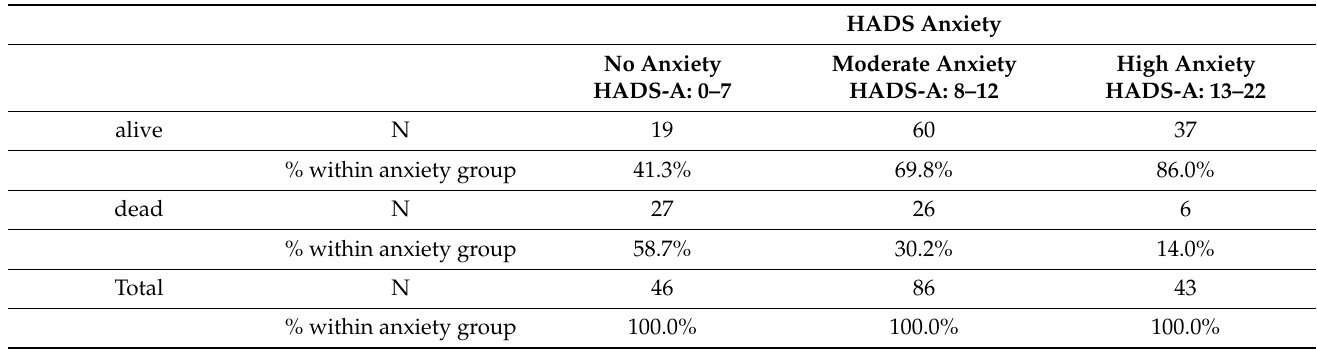
Table 3. HADS anxiety and survival after 12 years in 175 CAD patients (chi 2 20.8, p <